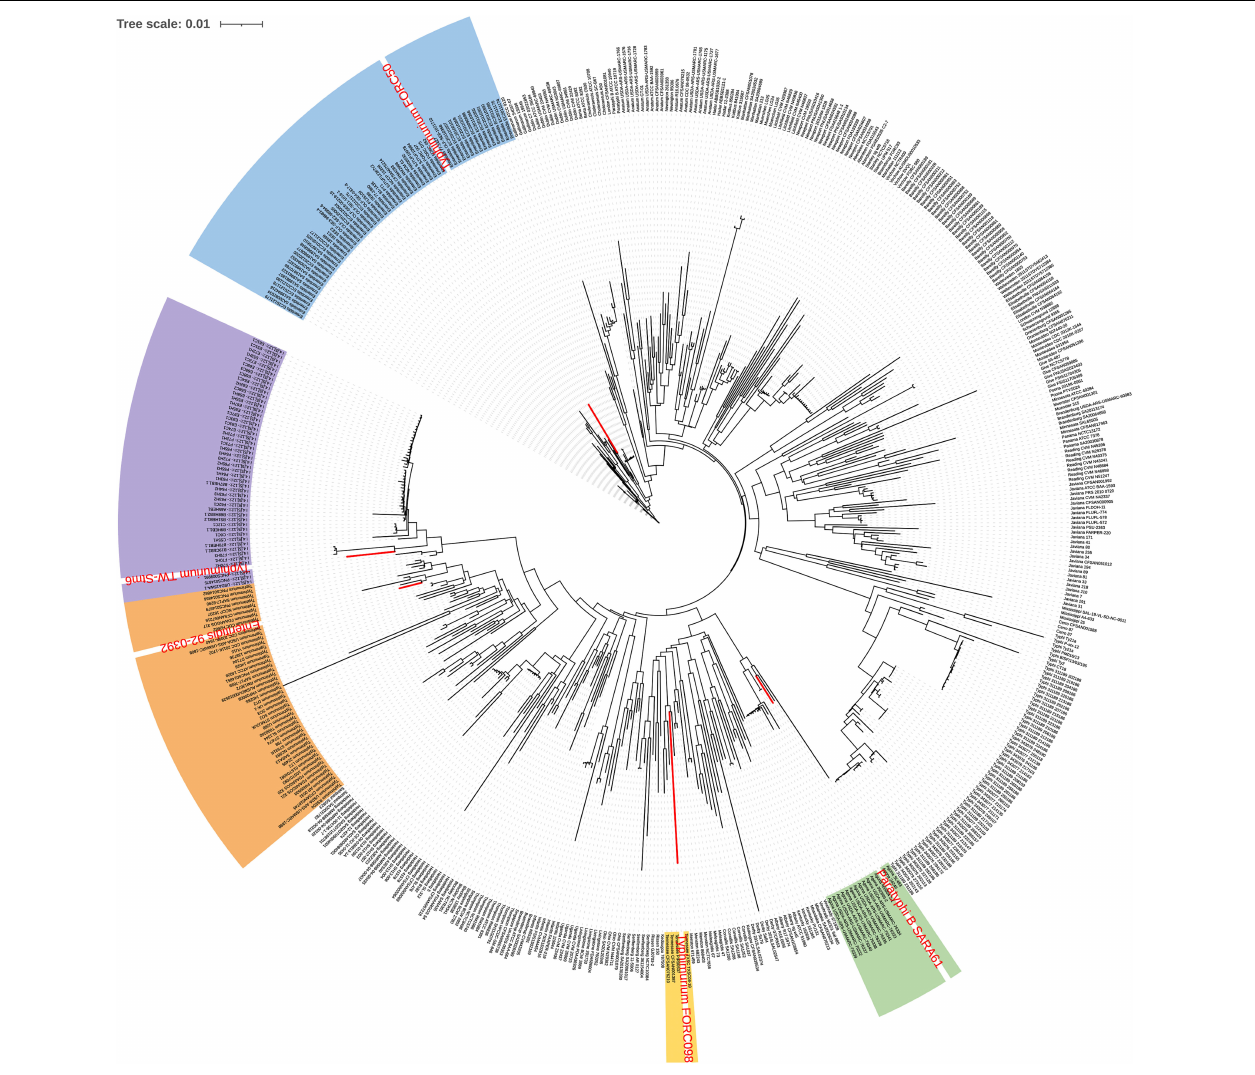
FIGURE 1 | Pangenome distribution of the 535 Salmonella genomes. The red letters in the circular dendrogram indicates the strains predicted by the incorrect serovars. The orange, purple, blue, green, and yellow backgrounds represent Typhimurium, I 4,[5],12:i:-, Enteritidis, Agona, and Tennessee,